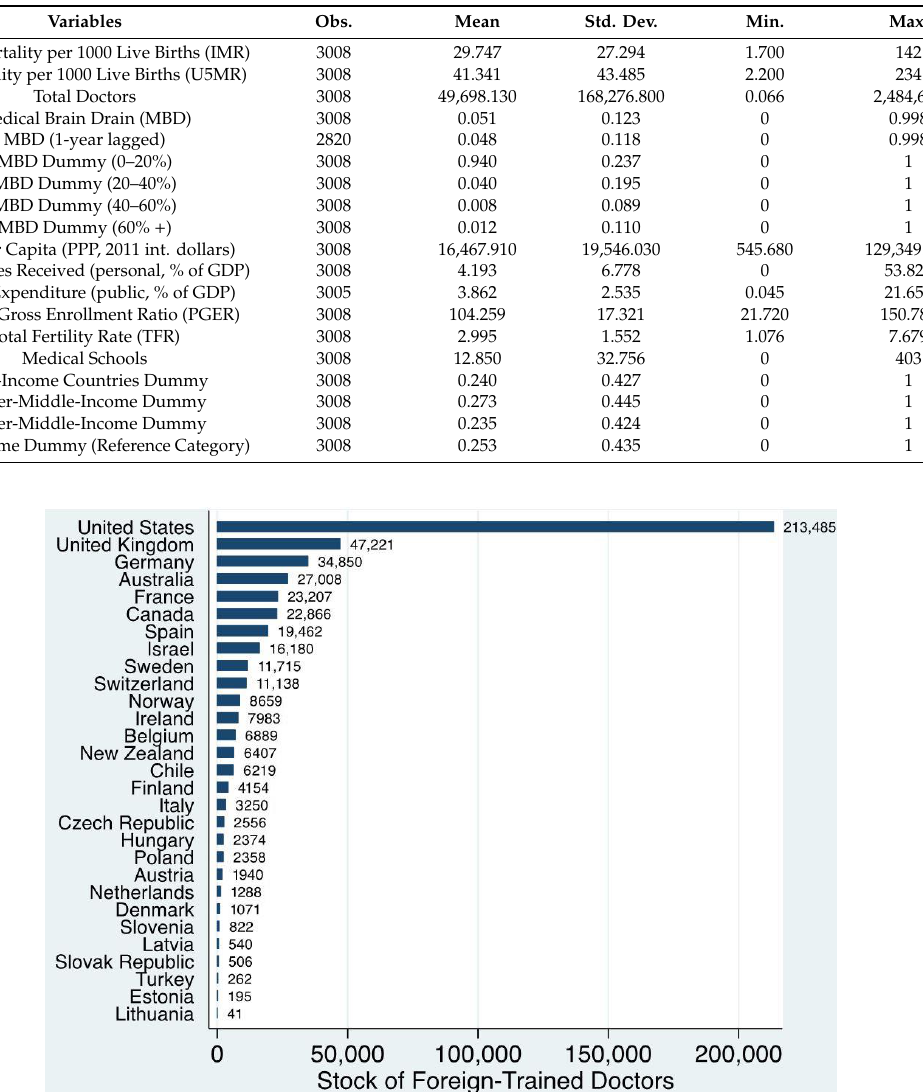
Figure 1. Stock of foreign-trained doctors in 29 destination countries in 2015 (or nearest year). Data source: OECD [48]. Foreign-trained is defined based on the place of training for all countries except Germany, where it is based on nationality, and Spain, where it is based on place of